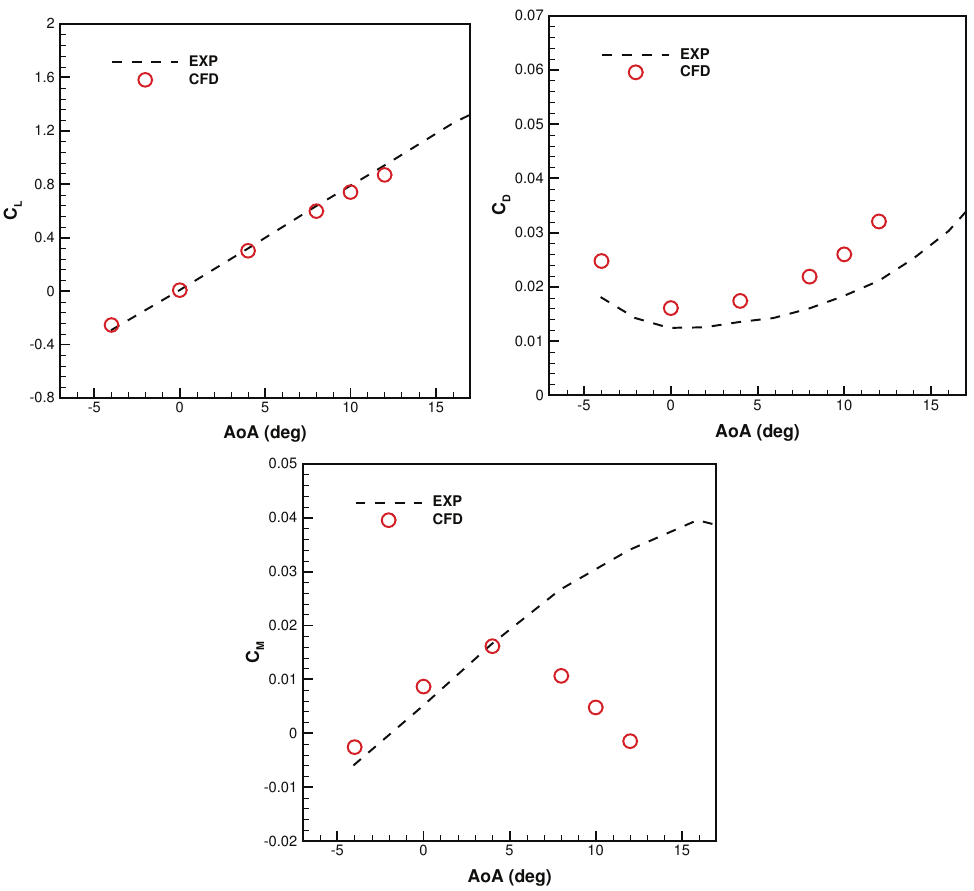
Figure 10. Lift ( top left ), drag ( top right ), and pitching moment ( bottom ) coefficients for the wing-fuselage system: present CFD results against experimental data [27].